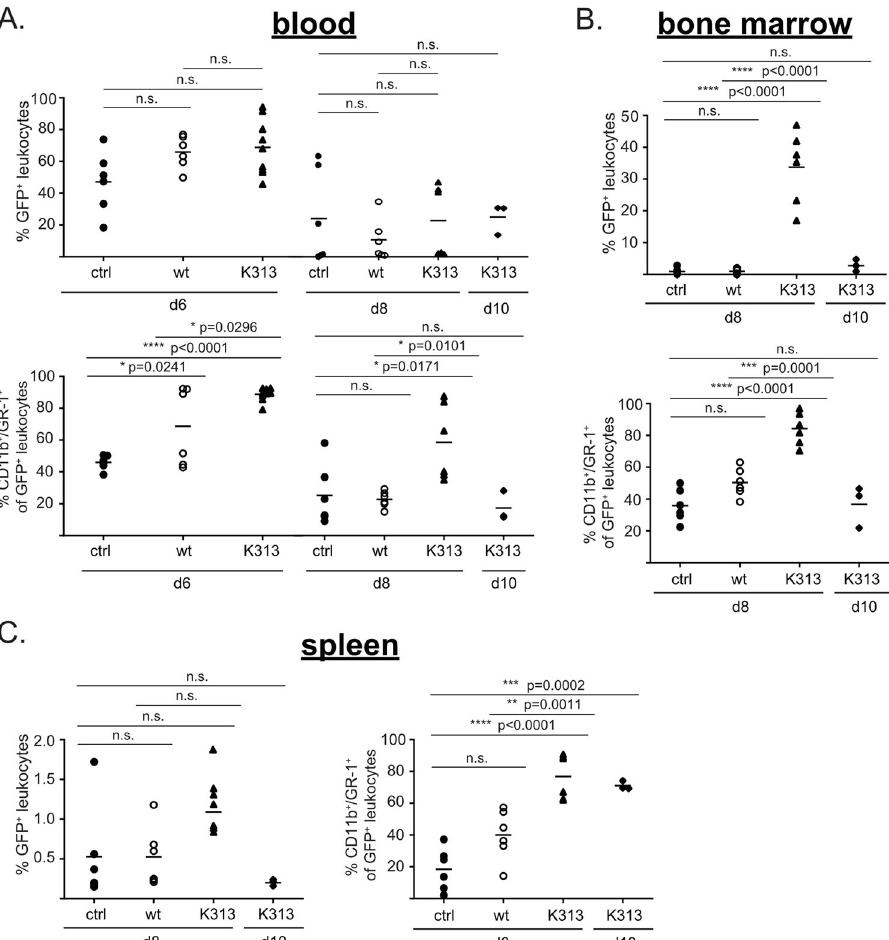
Fig. 2 C/EBP α -K313 maintains Hoxb8 neutrophils longer in vivo. The proportion of GFP-positive total leukocytes in blood ( A ), bone marrow ( B ) and spleen ( C ) and percentage of CD11b/Gr-1 double-positive GFP-positive Hoxb8 cells on day 6, 8 and 10 in mice engrafted with empty vector, wt C/EBP α or C/EBP α -K313-expressing Hoxb8 neutrophil progenitors. HoxB8 progenitors were transplanted together with bone marrow cells at a 10:1 ratio. Data represent absolute values and mean of two experiments with three mice per group (n.s. = non-signi fi cant, one-way ANOVA with multiple